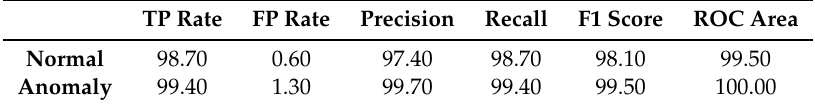
Table 16. Classification report for Bagging J48.